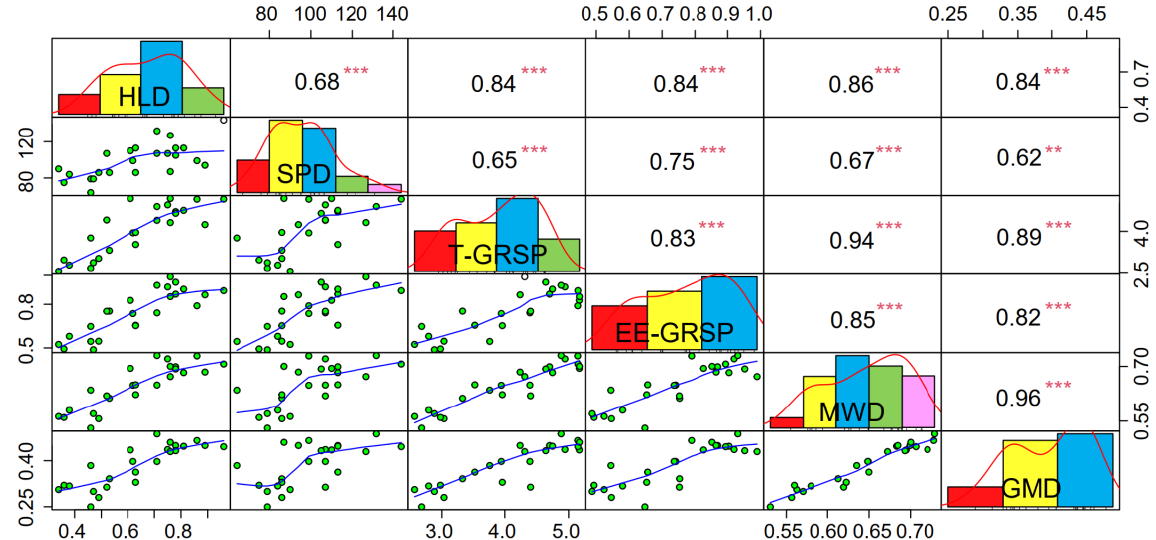
Figure 6. Correlation matrix among the selected variables related to AMF growth parameters, GRSP content, and soil-aggregate stability. HLD, hyphal length density; SPD, spore density; T-GRSP, total glomalin-related soil protein; EE-GRSP, easily extractable glomalin-related soil protein; MWD, mean weight diameter; GMD, geometric mean diameter (*** p < 0.001; ** p < 0.01).